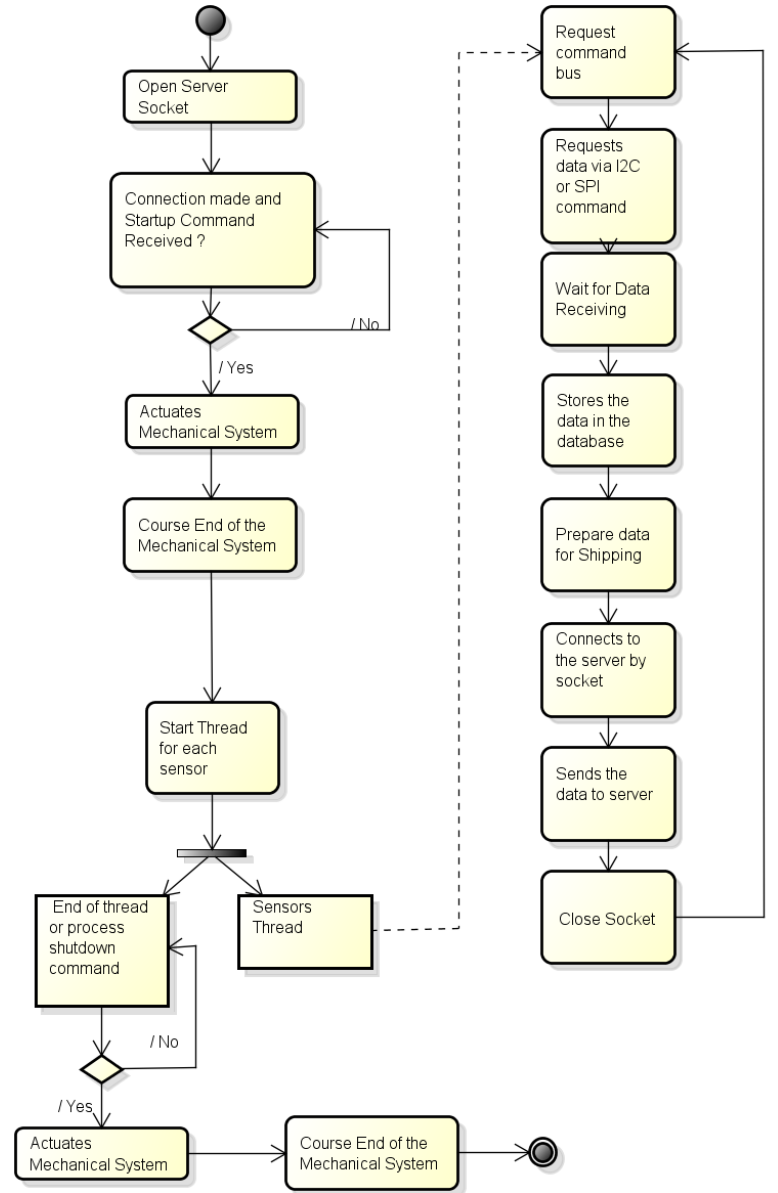
Figure 8. Algorithm of the process running in the Raspberry